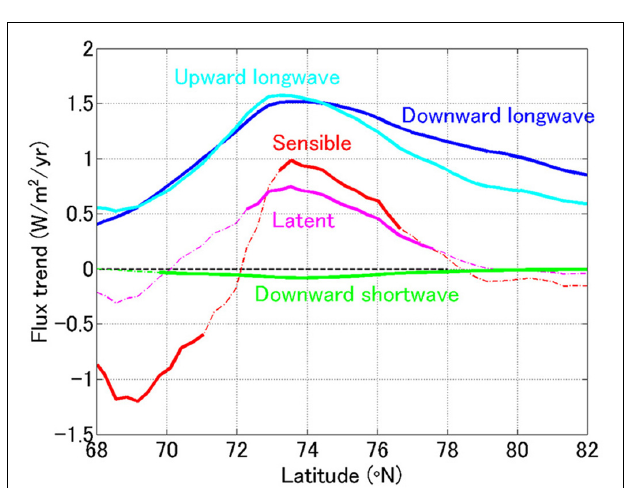
FIGURE 14 | Trends of surface heat fluxes averaged over the area of 167.5–174.0 ◦ W in October-November for 1979–2020. Thick solid lines denote statistical significance at the 95% confidence level, and thin chained lines show no